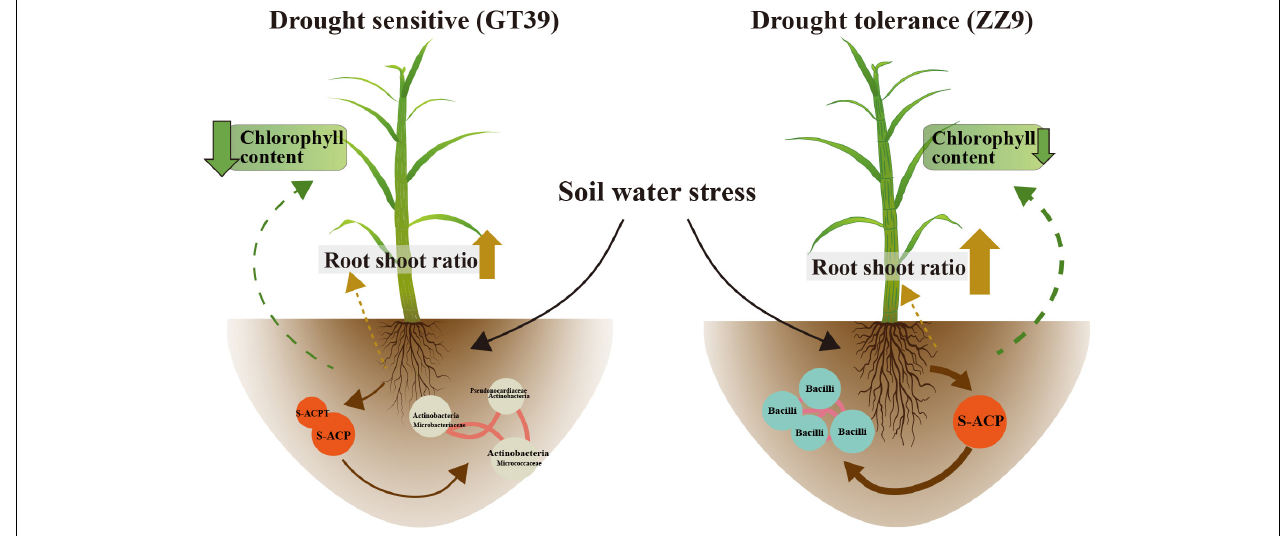
FIGURE 7 | Changes in chlorophyll content and root exudates of the two sugarcane varieties GT39 and ZZ9 under water stress conditions and their interaction with the main rhizosphere bacterial